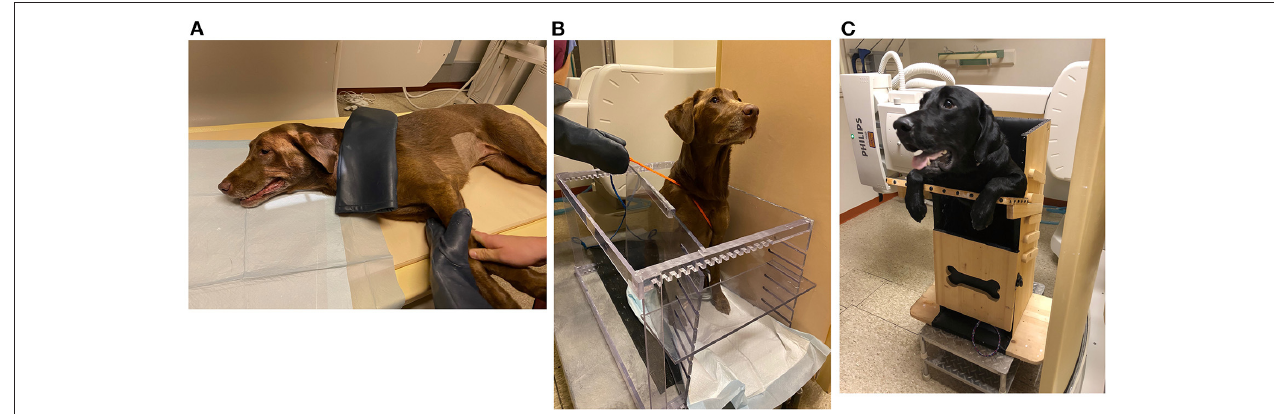
FIGURE 7 | Positioning of dog in swallowing fluoroscopy study. (A) A 5-year-old Labrador retriever undergoing a videofluoroscopic swallow study examination in lateral recumbency with physical restraint by trained personnel. (B) The same patient in (A) undergoing a videofluoroscopic swallow study examination in a polycarbonate kennel restraint device. (C) An 11-month-old Labrador retriever undergoing videofluoroscopic swallow study examination in a Bailey Chair due to history of regurgitation. The Bailey Chair acts as a restraining device and maintains the dog in an upright position, enabling gravity to assist with passage of boluses down the